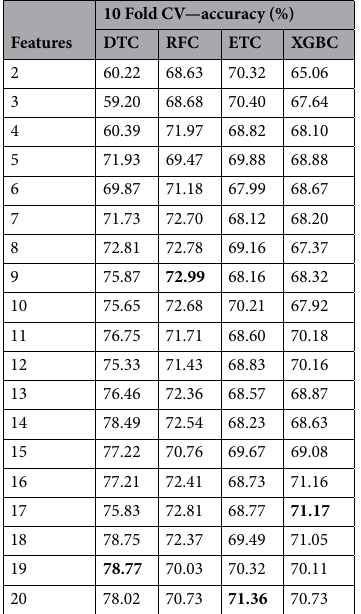
Table 2. Toxicity dataset, mean accuracy of 10-Fold CV with 100 replications for feature sets with cardinality ranging from 2 to 20. DTC, RFC, ETC, and XGBC trained and tested on feature sets with cardinality between 2 and 20.